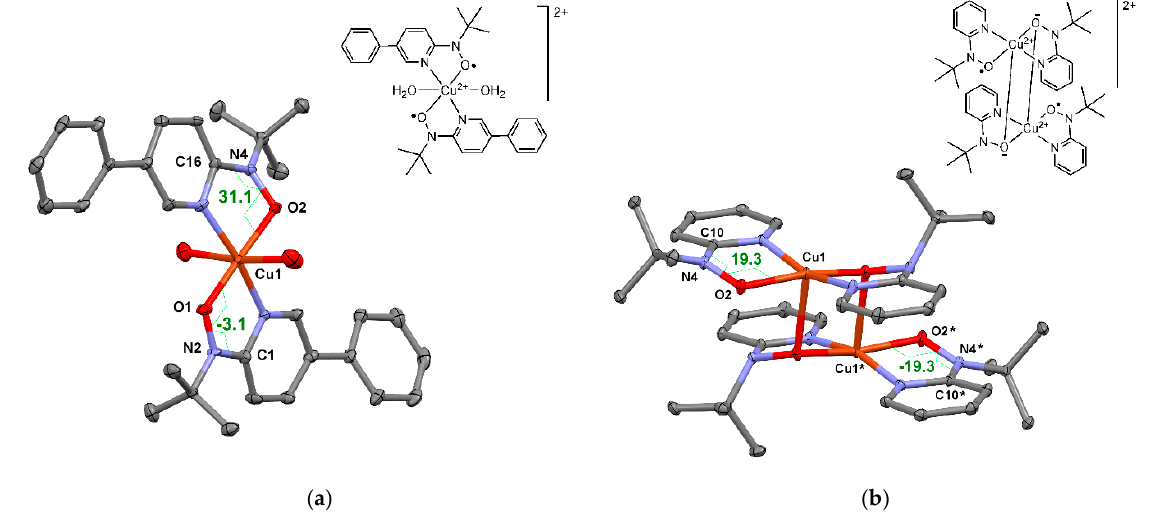
Figure 10. X-ray crystal structures of the LS phase of ( a ) [Cu(phpyNO) 2 (H 2 O) 2 ](BF 4 ) 2 measured at 94 K and ( b ) [{Cu 2+ (2pyNO ∙ )( μ -2pyNO – )} 2 ](BF 4– ) 2 at 50 K. Thermal ellipsoids are drawn at the 50% probability level. Counter anions and hydrogen atoms are omitted. Selected atomic numbering and torsion angles ( ϕ (Ni–O–N–C sp2 )) are indicated. Structural formulas are also shown. Adapted with permission from [111,112], published by the American Chemical Society, 2010.